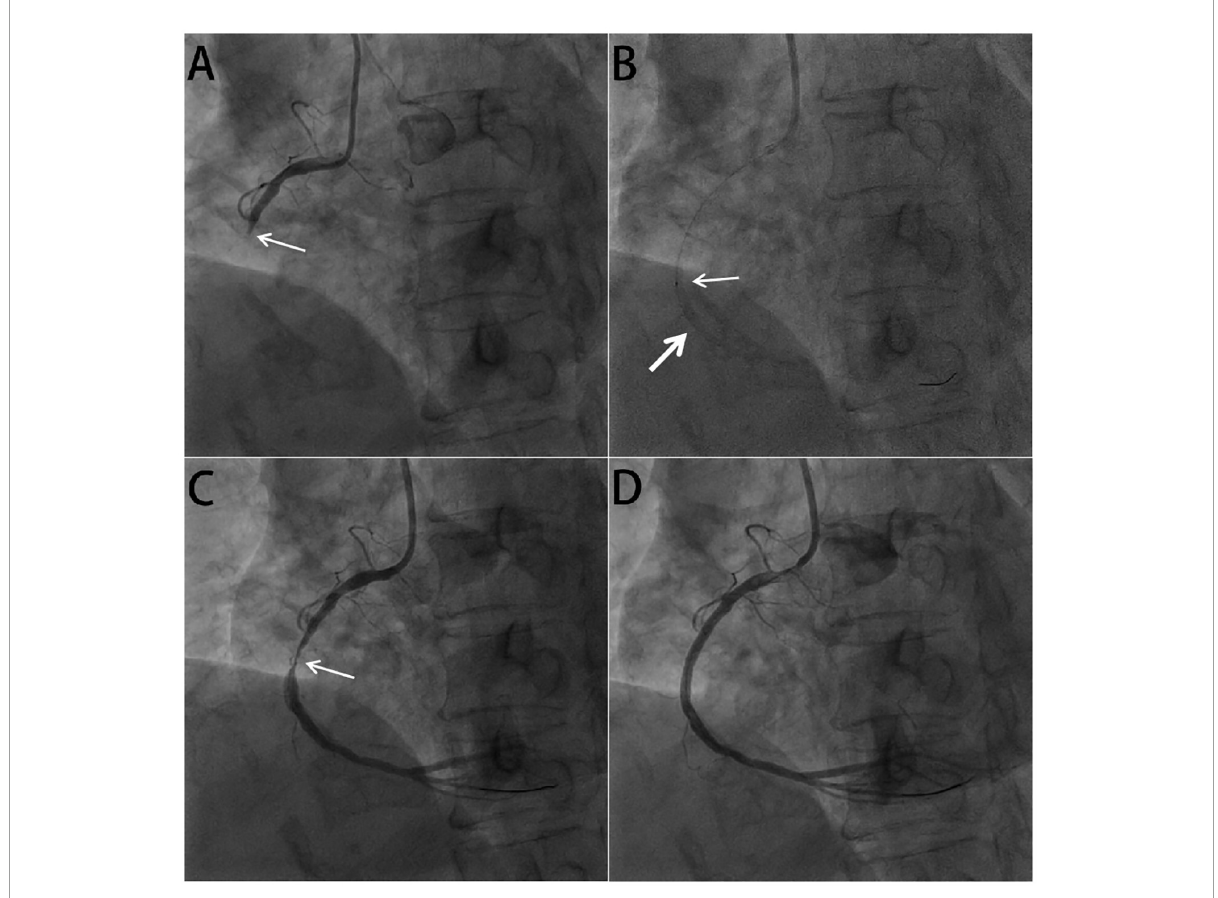
FIGURE3 Coronary angiogram in acute right coronary arterial occlusion. (A) The basal angiogram showed total occlusion of the right coronary artery distal segment with thrombus image. The arrow showed the occlusion. (B) The procedure of intracoronary artery retrograde thrombolysis (ICART) through the sheared balloon. The distal thrombus was gradually dissolved. The fine arrow showed the tip of the sheared balloon, and the coarse arrow indicated the thrombolytic agent with contrast agent to fill the occluded lumen. (C) After thrombolysis, the culprit lesion (arrow) in the middle of the right crown was observed. (D) A stent was implanted in the RCA to achieve